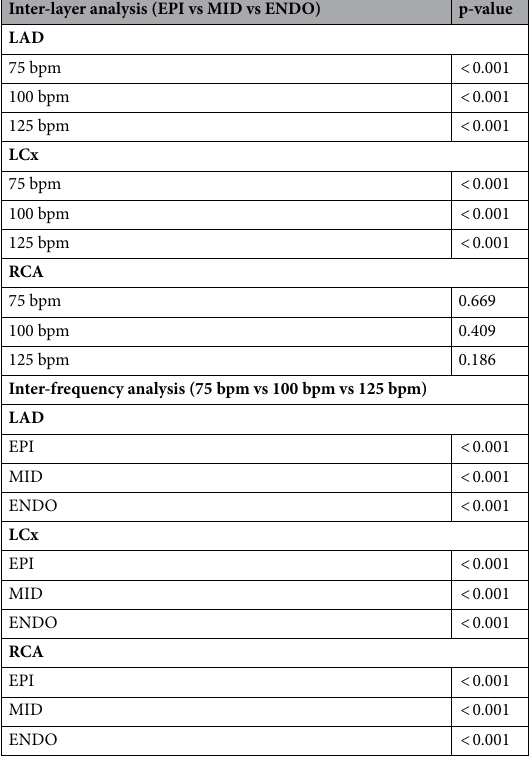
Table 2. Inter-layer (comparison of Q AF , b / Q SR across the different myocardial layers given a specific ventricular rate) and inter-frequency (comparison of Q AF , b / Q SR across the different simulated ventricular rates given a specific myocardial layer) ANOVA test results. EPI subepicardium, MID midwall, ENDO subendocardium, LAD left anterior descending artery, LCx left circumflex artery, RCA right coronary artery.